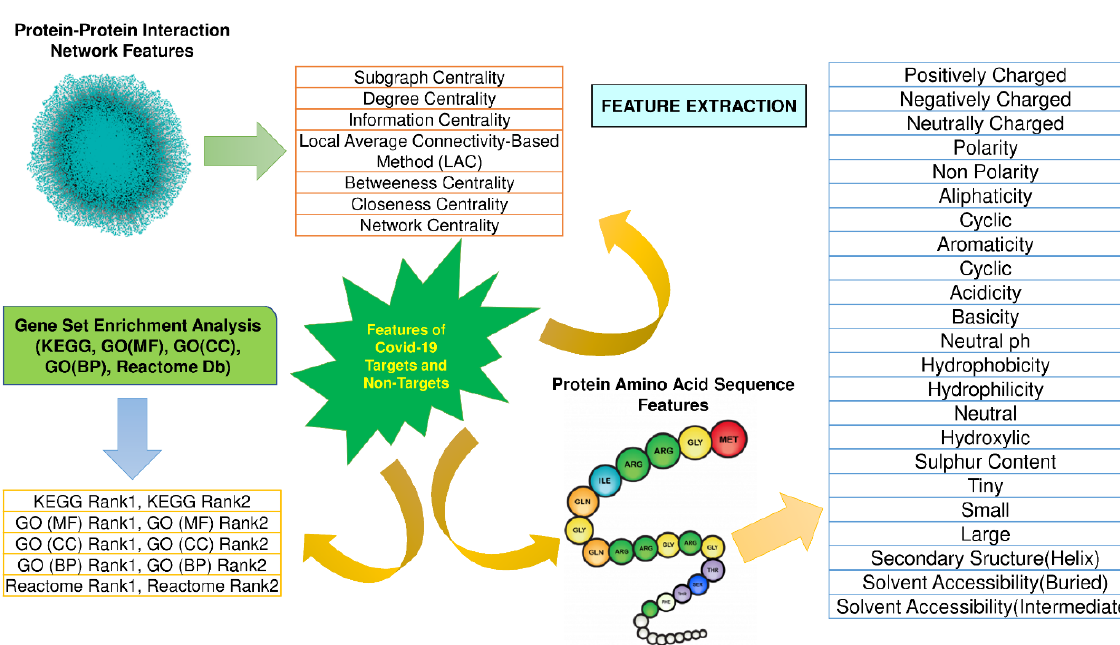
Figure 2. PPIN features Protein Sequence features, and GSEA Ranking features.